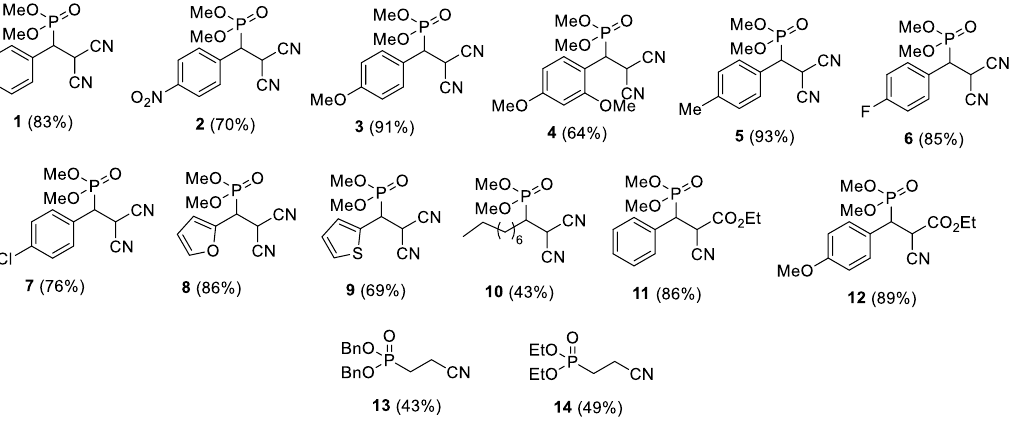
Figure 3. β -Phosphonomalononitriles 1 – 10 and β -phosphononitriles 11 and 12 obtained via an en-